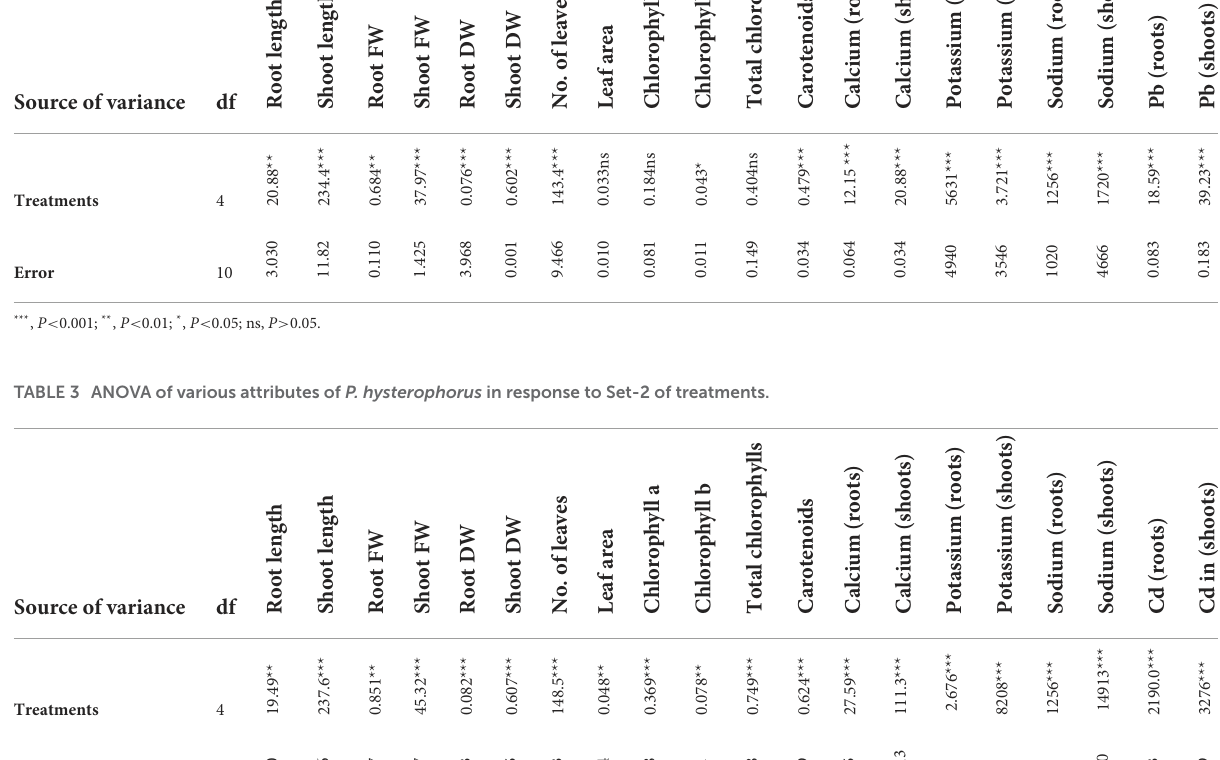
Source of variance